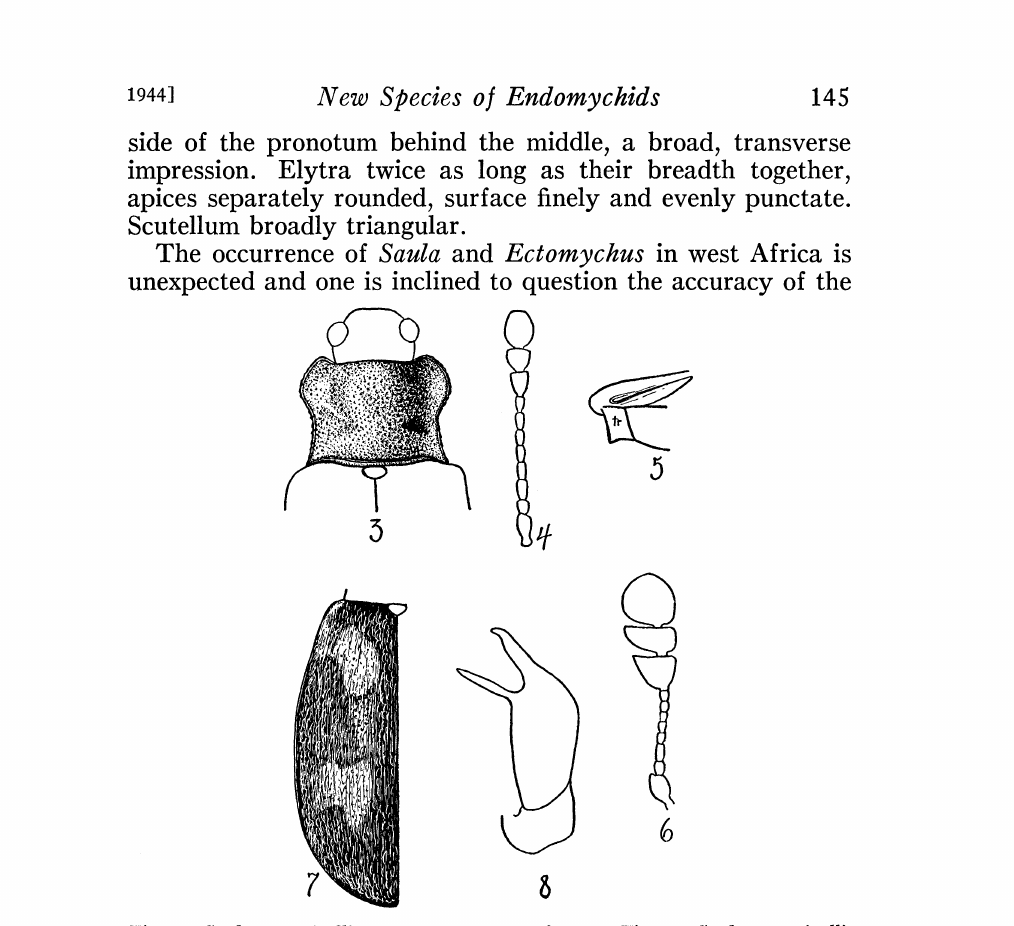
Fig. 3. Saula serraticollis n. sp., pronotum of type. Fig. 4. Saula serraticollis n. sp., antenna of type. Fig. 5. Ectomychus alricanus n. sp., hind trochanter of type. Fig. 6. Ectomychus a]ricanus n. sp., antenna of type. Fig. 7. Indalmus hirsutus n. sp., elytron of type. Fig. 8. Indalmus hirsutus n. sp., aedeagus of